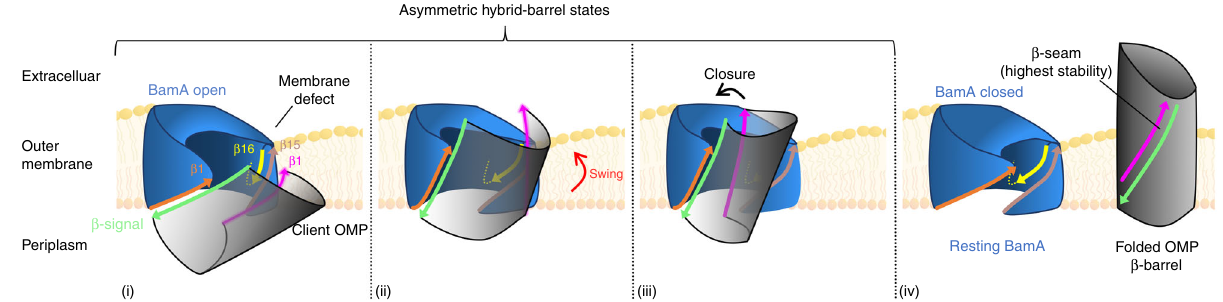
Fig. 7 Model of bacterial outer membrane protein assembly. Red arrows indicate possible conformational changes. After an OMP (grey) is targeted to the OM, it interacts with the BamA β -barrel (blue). Initially the C-terminal β -strand of the OMP ( β -signal, green) forms a β -seam with BamA β 1 (orange) to create an asymmetric hybrid barrel (i). It is not yet clear if the OMP begins to fold before or after the formation of this interface. Subsequently the fi rst β - strand of the OMP (magenta) forms a low stability interface with the outward-facing surface of BamA β 15/16 (salmon/yellow) (ii). A large-scale movement of the OMP into the membrane ( ‘ swing ’ ) is aided by the rotation of BamA β 1- β 8, the perturbation of the lipid bilayer by the wedge-shape of the BamA β -barrel, and the dynamicity of β 16. The asymmetry between the two interfaces favours the closure of the client β -barrel (iii) and its release into the lipid bilayer in a native conformation (iv). Our results suggest that a loop of the MBP − 76 EspP passenger domain is exposed on the cell surface prior to most of the